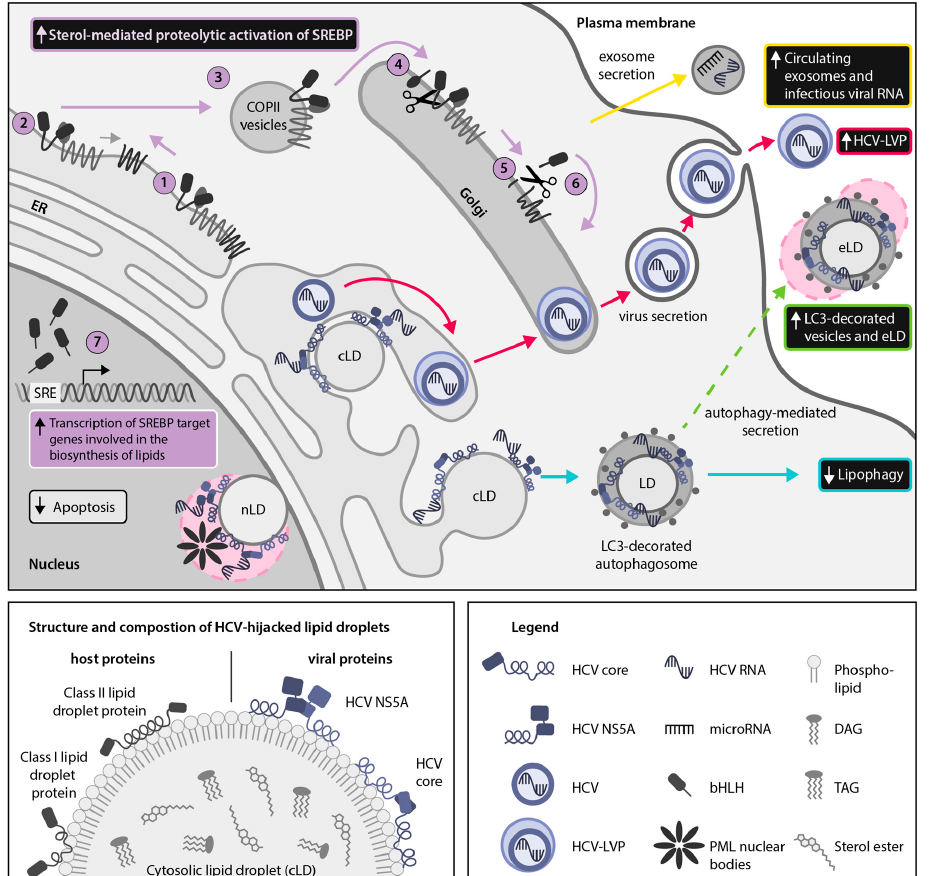
Figure 2. Hepatitis C virus (HCV) hijacks sterol regulatory element-binding protein (SREBP)-regulated host lipid metabolism. HCV relies on manipulation of host lipid metabolism for virion packaging and release as lipid-coated lipoviroparticles (LVPs) (red arrows). Thus, HCV infection results in a multi-faceted disruption of lipid homeostasis, including remodeling of intracellular lipids into a membranous web, increased sterol-mediated SREBP activation and transcription of SREBP target genes (purple arrows: ( 1 – 7 )), reduced autophagic catabolism of lipid droplets (LDs) (cyan arrows) and enhanced secretion of exosomes containing infectious viral RNA and host microRNAs that regulate lipid metabolism (yellow arrows). Here, we propose that the cytoplasmic LD (cLD)-associated HCV proteins core and non-structural protein 5A (NS5A) may also use nuclear LDs (nLDs) as a sequestration platform for interfering with host LD-associated proteins (pink circle). In the nucleus, LD-association of NS5A and core may facilitate their interaction with promyelocytic leukemia (PML) nuclear bodies, resulting in inhibition of host cell apoptosis. In addition, we hypothesize that hijacking of secreted microtubule-associated protein light chain 3 (LC3)-decorated vesicles containing LDs may be an additional mechanism for release of HCV virions, viral proteins or infectious viral RNA to escape the host cell (green arrow). Hypothetical pathways are highlighted with dotted lines.